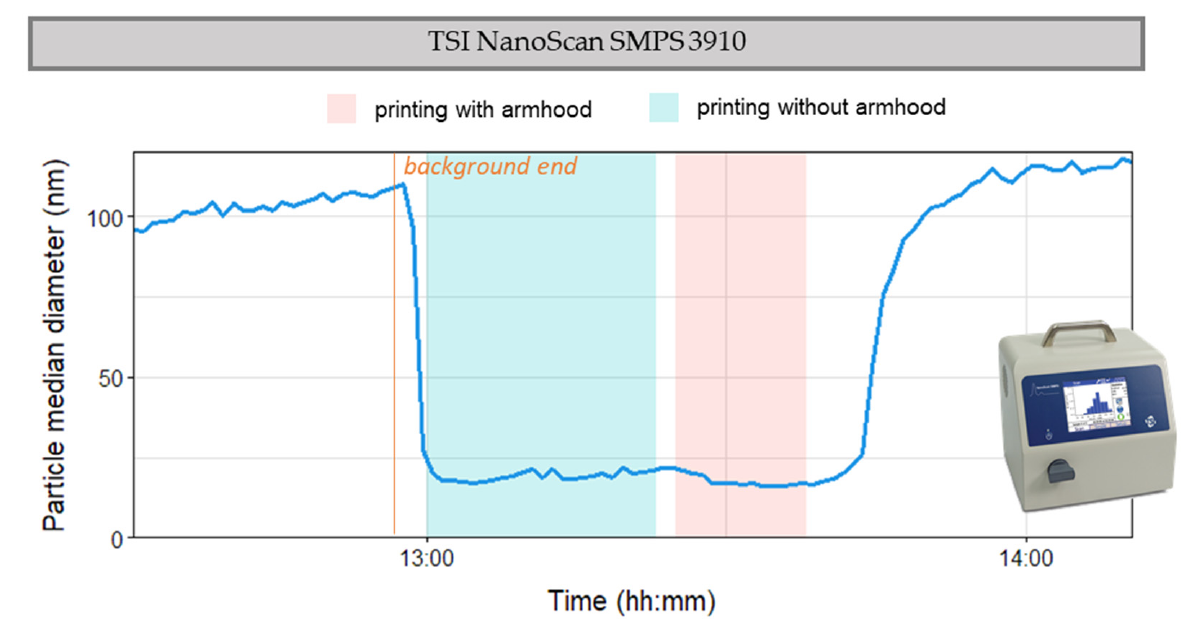
Figure 10. Particle size distribution for Case 4b.